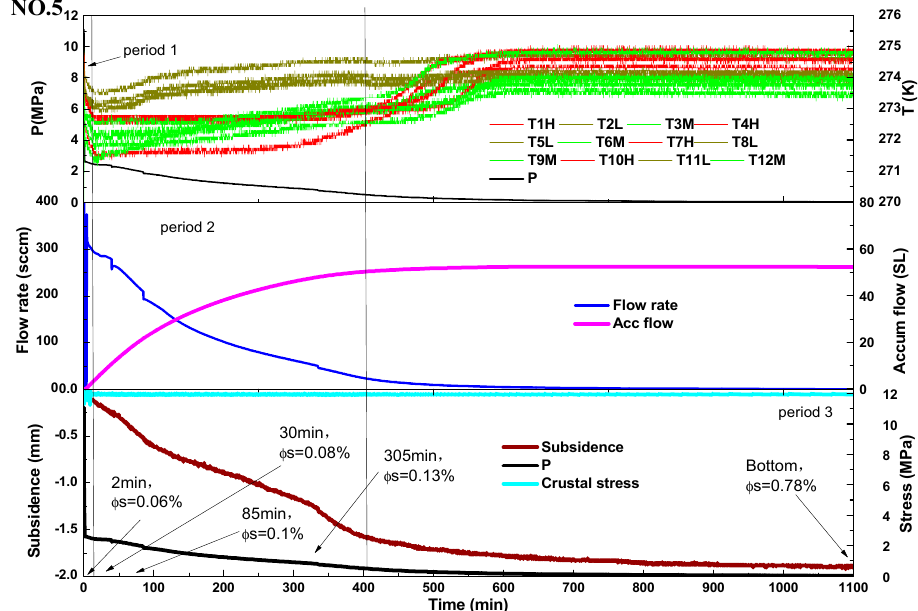
Figure 4. Experimental results of the pressure, temperature, flow rate, and subsidence rate. (Here, T indicates temperature, 1–12 indicates the alignment of the temperature sensors; H, L and M mean the height of temperature sensors in layers H, M and L; ∅ s indicates the sand rates in produced water.)